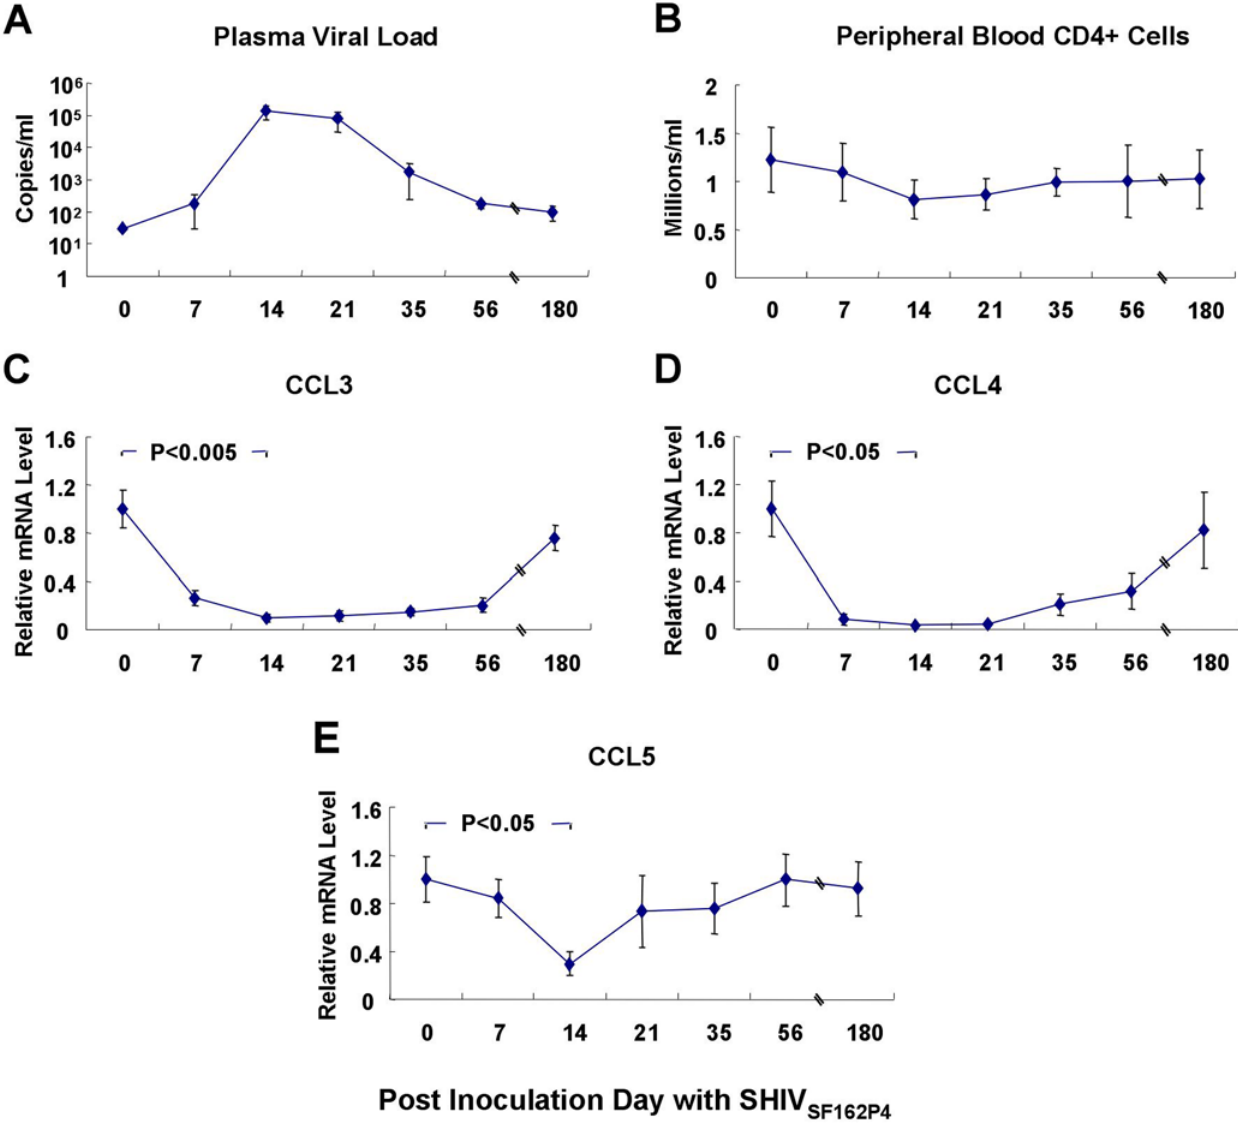
Figure 1. SHIV SF162P4 loads in plasma (A), CD4 + T cell counts in peripheral blood (B), relative CCL3 (C), CCL4 (D) and CCL5 (E) gene expression levels in PBMCs at PID 0-180 with SHIV SF162P4 . Each point on the graph represents the mean fold change in gene expression relative to pre-infection level 6 SE (n=5). doi:10.1371/journal.pone.0000726.g001 PLoS ONE |